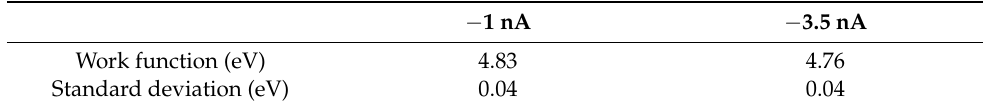
Table 1. The electron work function of APS Hap coatings charged with constant current values of − 1 and − 3.5